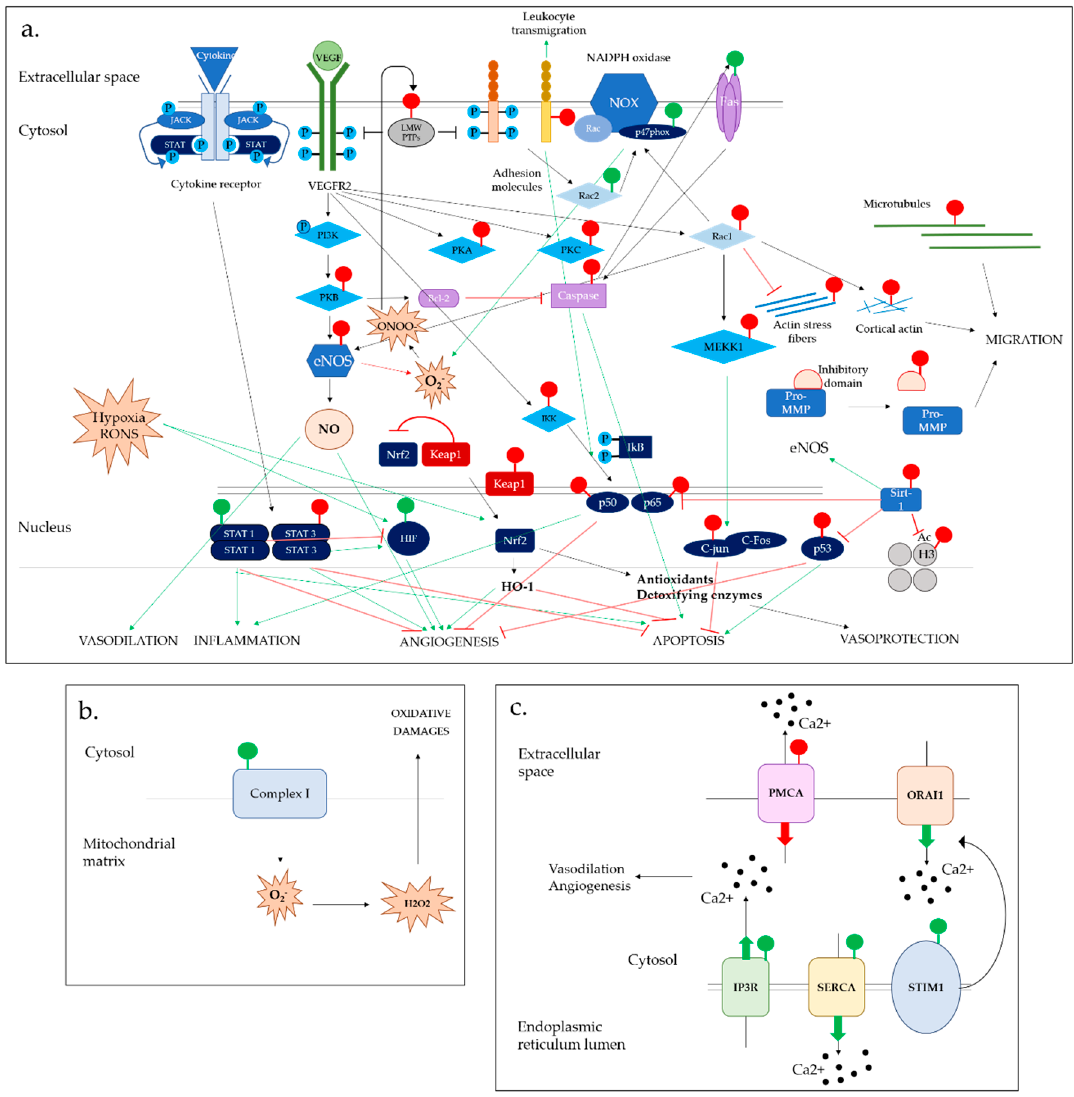
Figure 3. Overview of the interlinked effects of S-glutathionylation in major EC functions via the alteration of ( a ) major signaling pathways in cytosol and nucleus ( b ) RONS formation in mitochondria ( c ) calcium-dependent signaling in the endoplasmic reticulum.